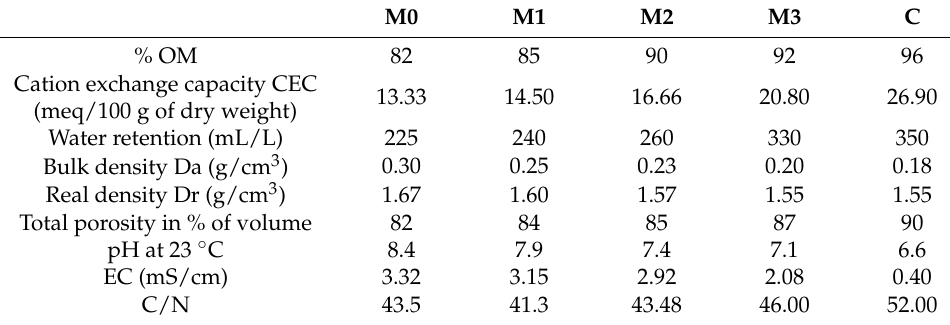
Table 1. Physico-chemical characteristics of the substrates mixtures (M) and the Control (C).